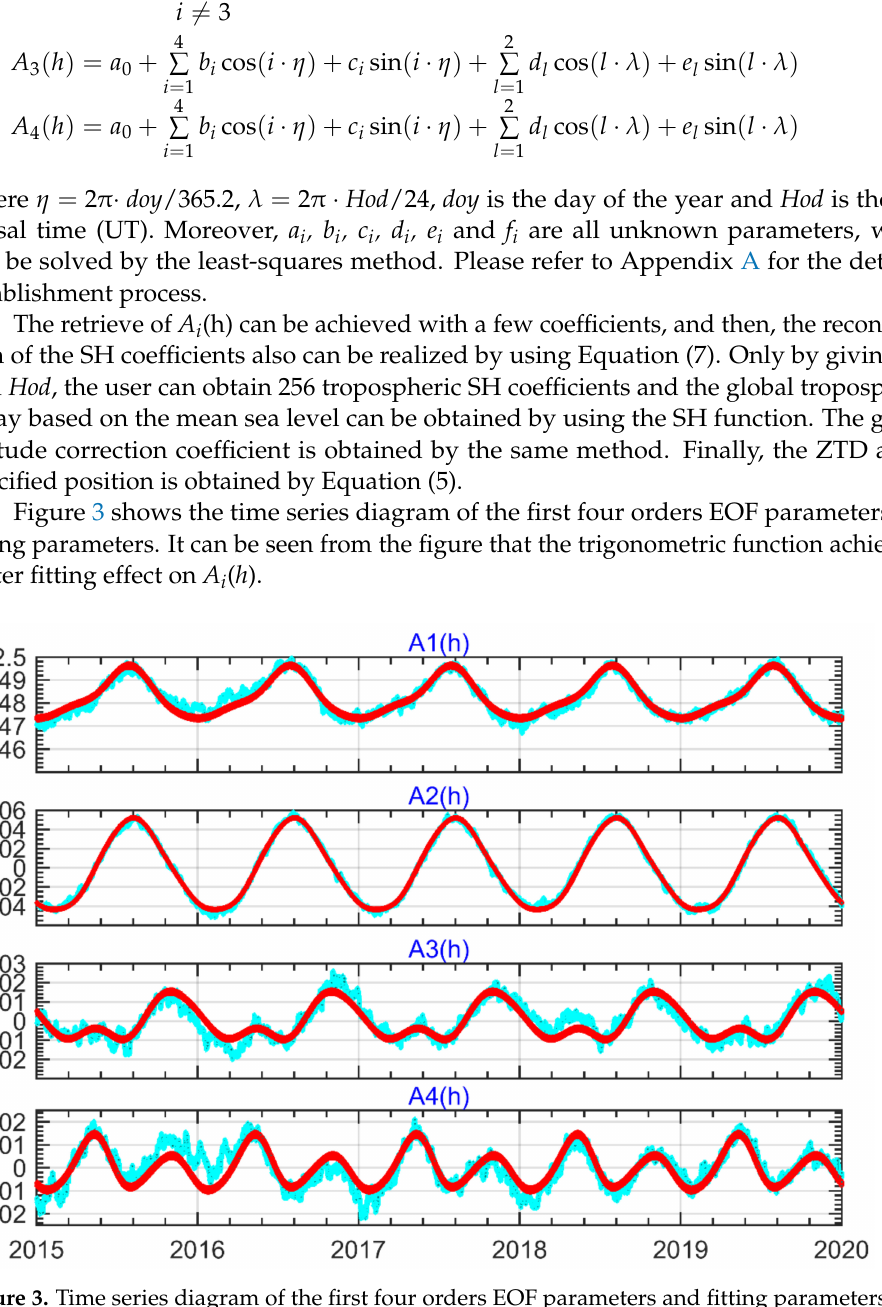
Figure 3. Time series diagram of the first four orders EOF parameters and fitting parameters. Red dots indicate the fitting data, and cyan dots indicate the